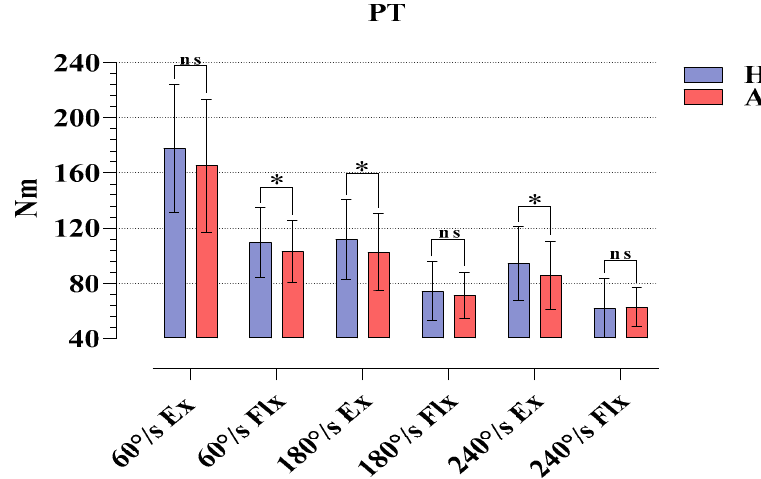
Figure 1. Comparison of PT values obtained in isokinetic tests for HK and ACLR. ns, nonsignificant; * p < 0.05; HK, healthy knee; ACLR, anterior cruciate ligament reconstruction knee; Ex, extension; Flx, flexion.